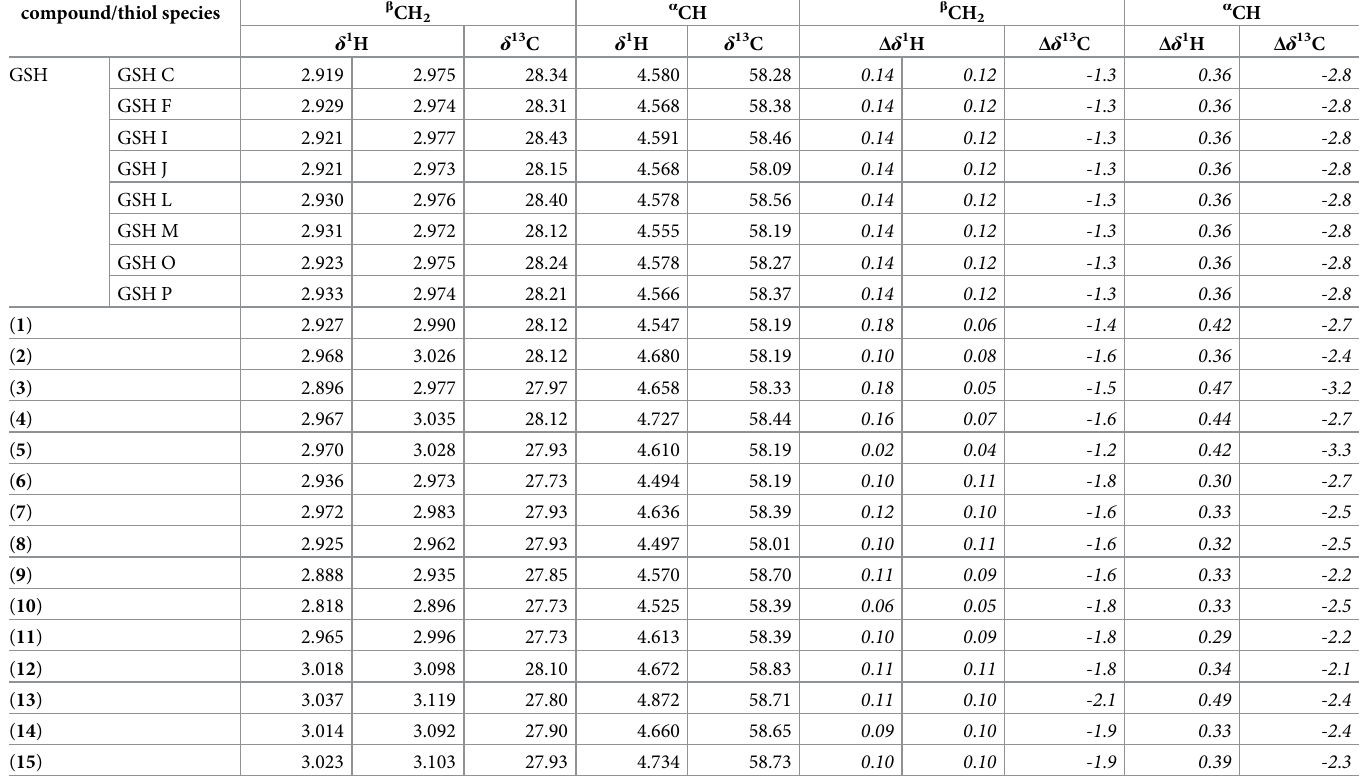
Table 4. The species-specific chemical shifts together with the thiolate-specific protonation shifts determined for the additional compounds studied (beyond cyste- ine and cystine) bearing thiol moiety. The uncertainty of determination for chemical shift on the ppm scale is 0.001 and 0.01 for 1 H and 13 C chemical shift values, respec- tively. Mean value and standard deviation of the protonation shifts ( Δδ ) are: 0.14 ± 0.07, 0.08 ± 0.05, -1.62 ± 0.28, 0.37 ± 0.05, -2.64 ± 0.30 for the nuclei found in the table, respectively. compound/thiol species β CH